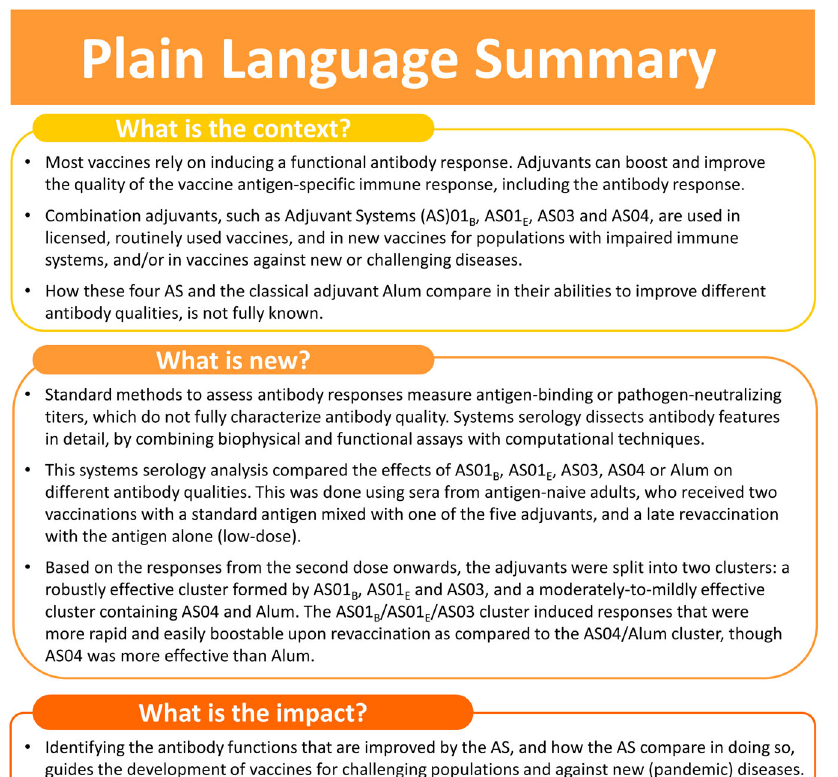
Fig. 6 Plain language summary. Study overview and main implications described in a manner that is understandable by a non-specialist